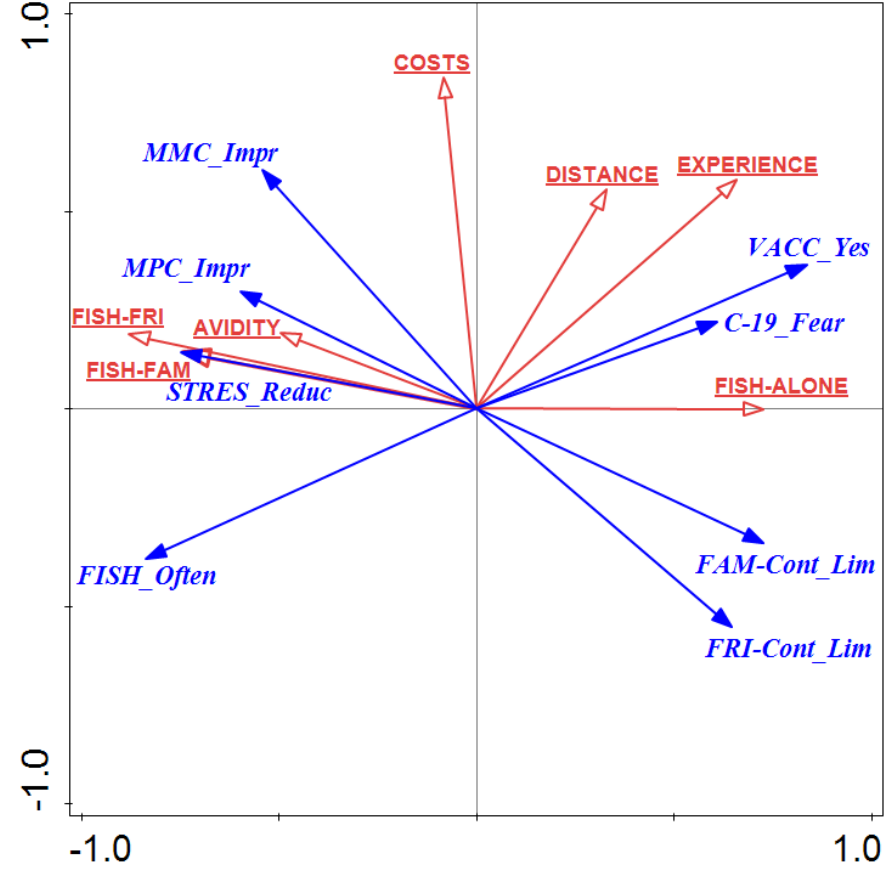
Figure 1. Ordination triplot of redundancy analysis (RDA) of anglers’ feelings and behavior induced by the COVID-19 pandemic (response data-blue arrows) in relation to their angling preferences and engagement (explanatory variables—red arrows. Both canonical axes are linear combinations of explanatory variables. Vectors pointing in the same direction indicate a positive correlation, vectors crossing at right angles indicate a near-zero correlation, while vectors pointing in opposite directions show a high negative correlation. The closer the group is to the center of the ordinal space, the more averaged the explanatory variables are. Abbreviations: STRES_Reduc, feeling of stress reduction by angling; MPC_Impr, feeling of improvement in physical condition; MMC_Impr, feeling of improvement in mental condition; VACC_Yes, positive attitude toward vaccination against COVID-19; C-19_Fear, feeling afraid of getting sick from COVID-19; FAM-Cont_Lim, limiting contact with family; FRI-Cont_Lim, limiting contact with friends; FISH_Often, fishing more often during the pandemic.